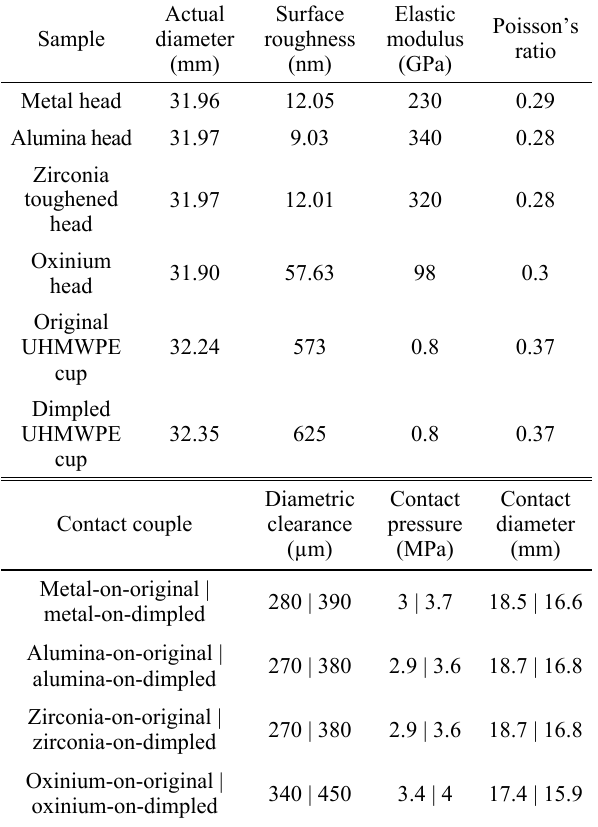
Table 1 Overview of the test samples and contact